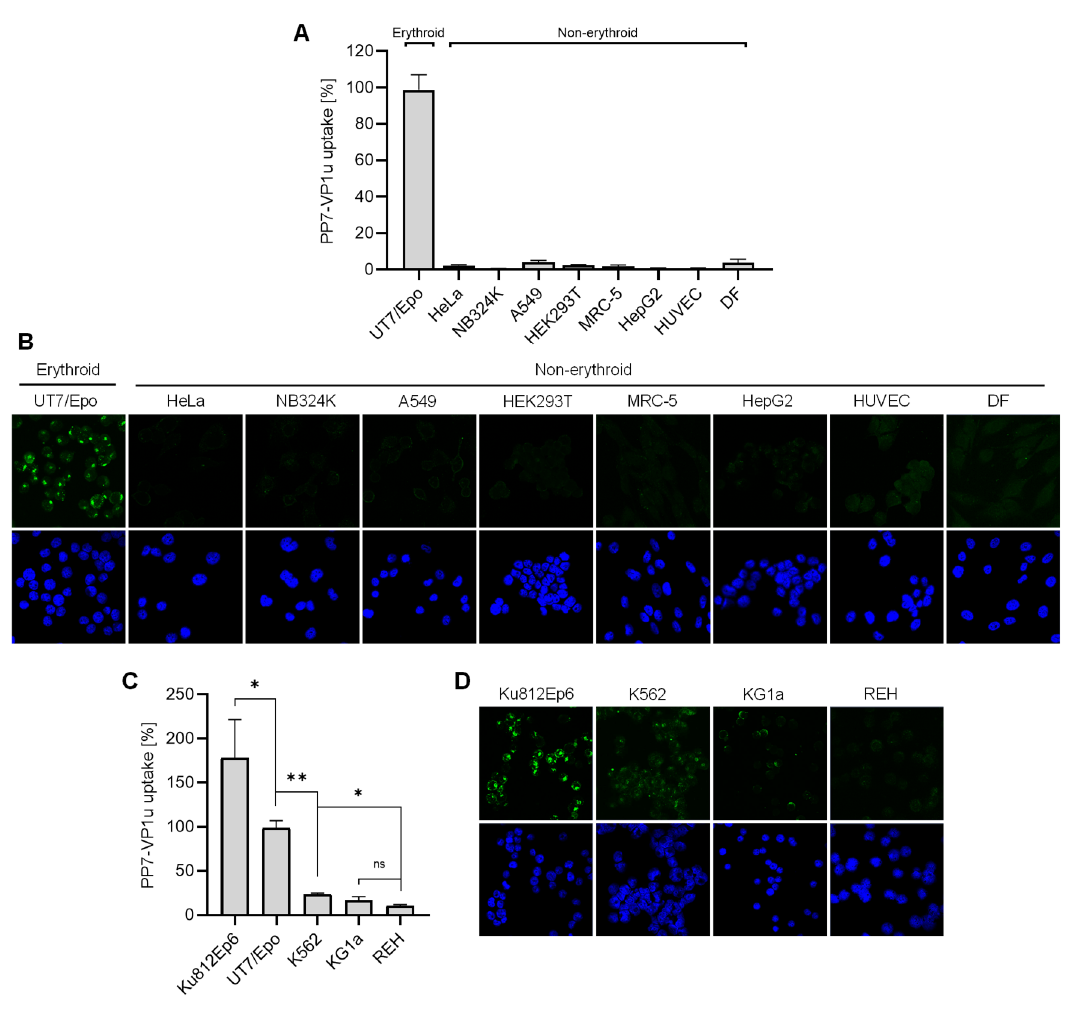
Figure 3. Expression profile of VP1uR in erythroid and non-erythroid cells. PP7-VP1u was incubated with different human cell types derived from non-erythroid tissues for 30 min at 37 °C. UT7/Epo served as a positive control. The internalized constructs were quantified by RT-PCR ( A ) and detected by fluorescence confocal microscopy ( B ). PP7-VP1u was incubated with different human hematopoietic cell lines for 30 min at 37 °C. UT7/Epo served as a positive control. The internalized constructs were quantified by RT-PCR ( C ) and detected by fluorescence confocal microscopy ( D ). All samples were treated with trypsin before RNA extraction to remove bound but not internalized constructs. The quantitative RT-PCR results are presented as the mean ± SD of three independent experiments. ** p < 0.01; * p < 0.05.